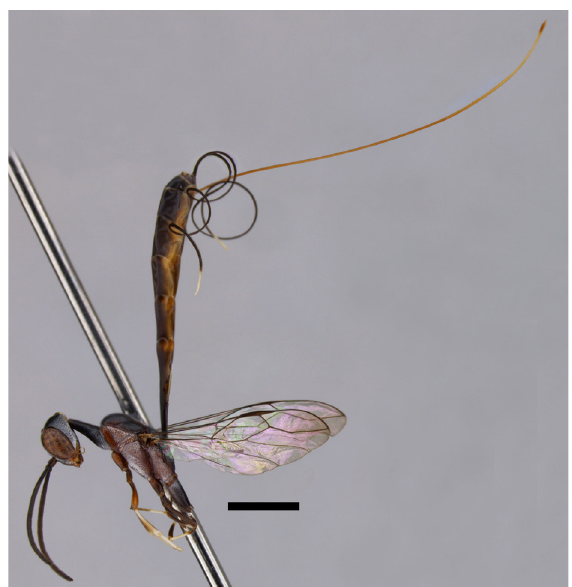
Figure 2. Gasteruption brasiliense (Blanchard, 1840), habitus. Scale bar = 2